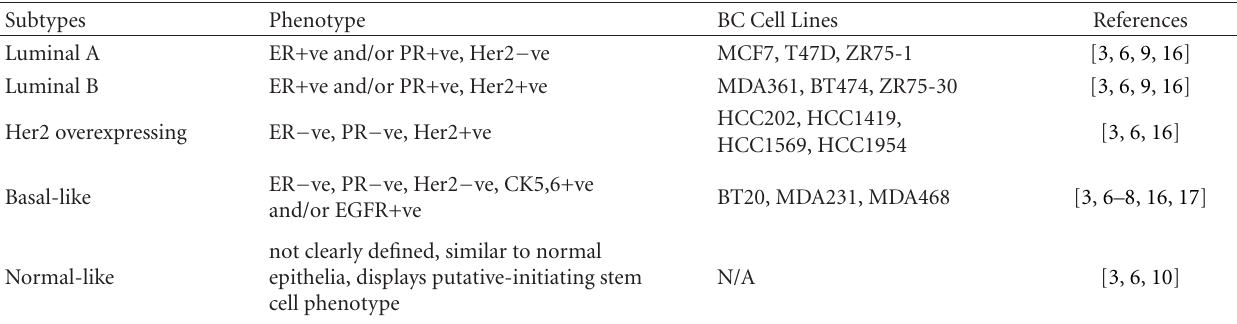
Table 1: The five distinct subtypes of breast cancer and their corresponding